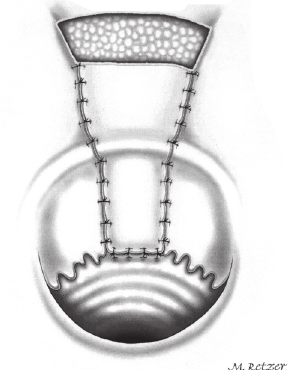
Table 1 - Etiology of Anal Stenosis. Causes